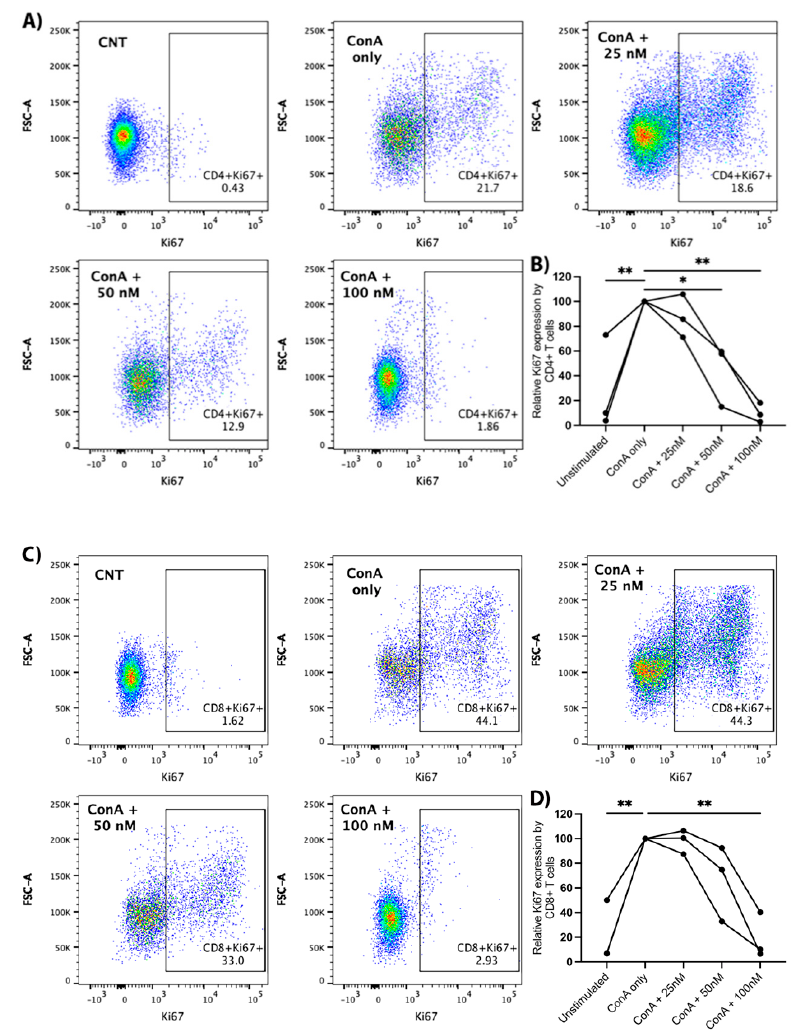
Figure 5. Proliferative effects of arginase on CD4+ and CD8+ T-lymphocytes. PBMCs from three dogs were incubated in complete media, complete media with ConA (5 µg/mL), or complete media with ConA (5 µg/mL) and indicated concentrations of arginase (25–100 nM) for two days prior to flow cytometry analysis. Cells were gated on the lymphocyte cloud, single cells, live cells, CD3+, and CD4+CD8 − or CD4 − CD8+ (Supplementary Figure S1C). Representative scatter plots ( A ), and summary graph ( B ) show the proportion of Ki67+ CD4+ T-lymphocytes treated with/without ConA and increasing concentrations of arginase. Representative scatter plots ( C ) and summary graph ( D ) show the proportion of Ki67+ CD8+ T-lymphocytes treated with/without ConA and increasing concentrations of arginase. Lines connect data points from each individual dog. * p < 0.05; ** p ≤ 0.01; n = 3.